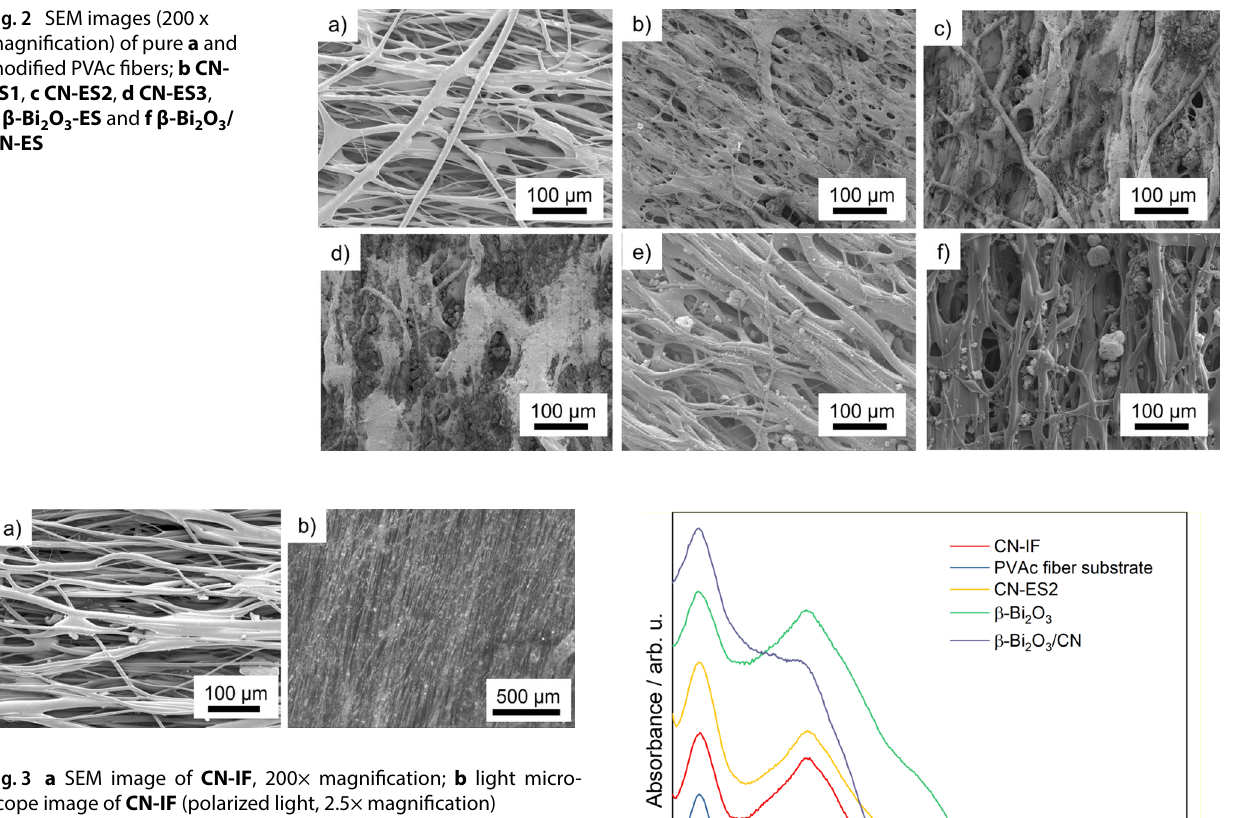
Fig. 2 SEM images (200 x magnification) of pure a and modified PVAc fibers; b CN- ES1 , c CN-ES2 , d CN-ES3 , e β-Bi O -ES and f β-Bi 2 3 CN-ES